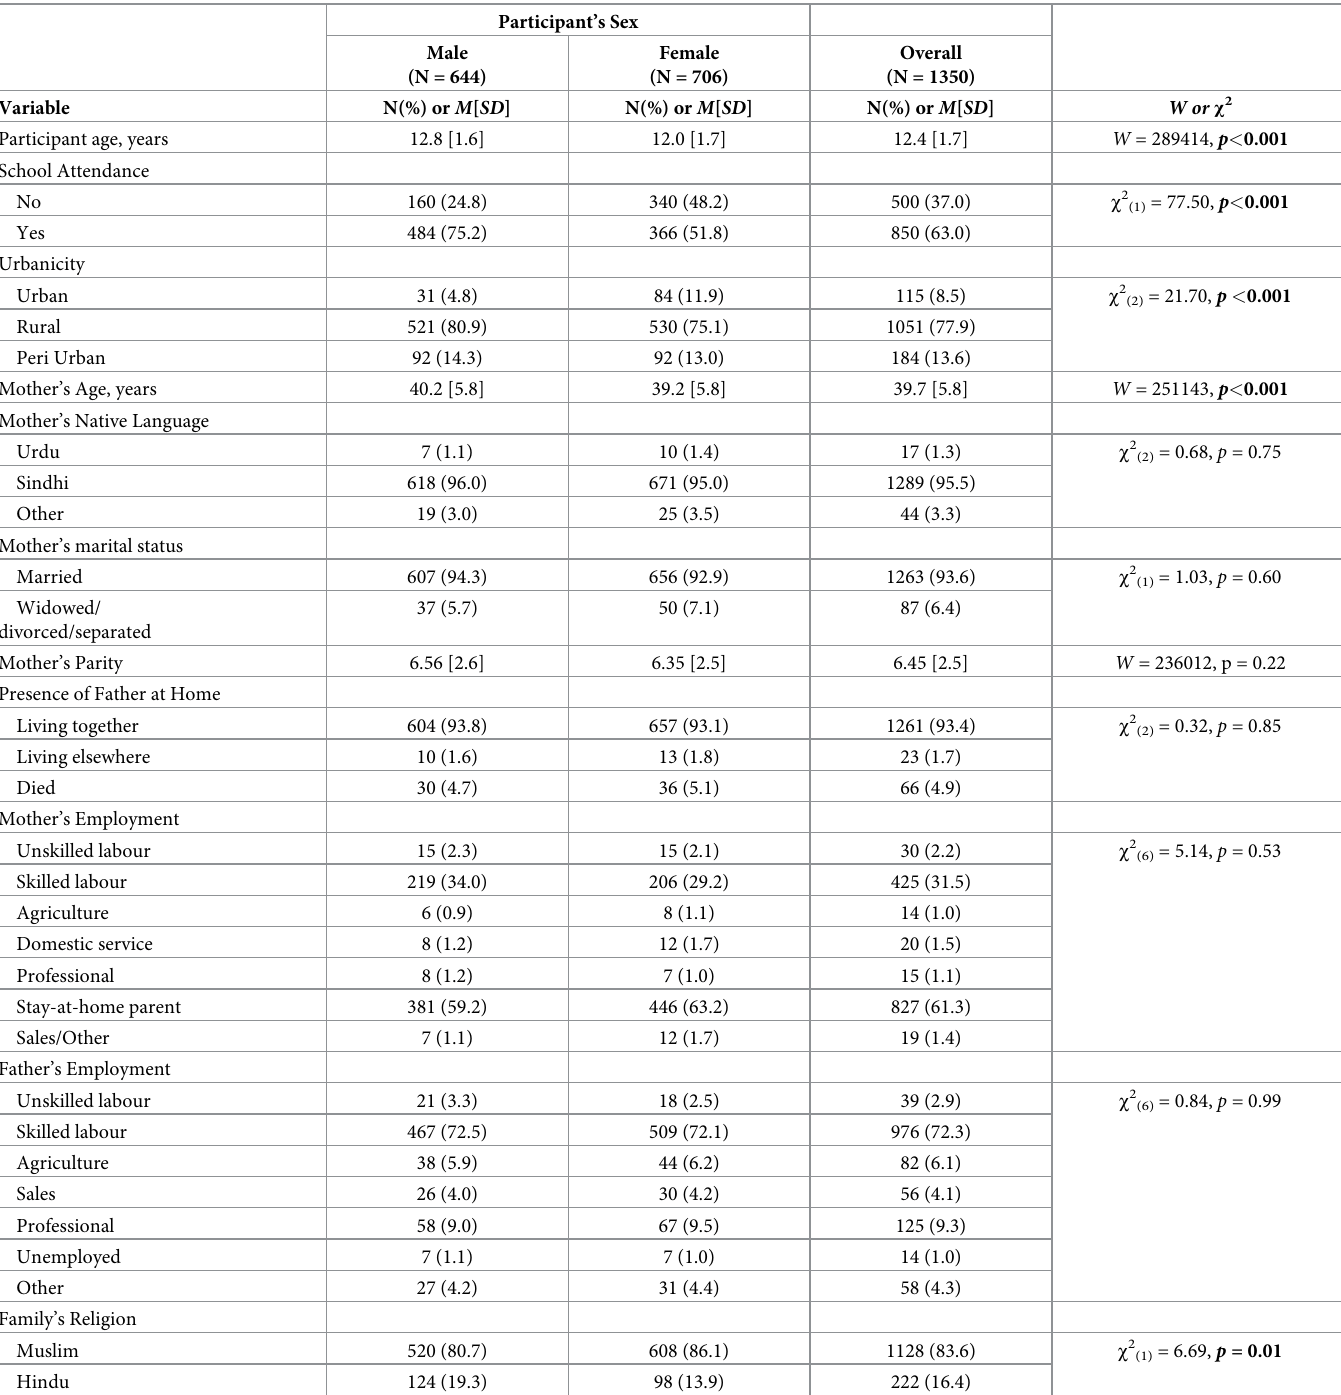
Table 1. Demographic and family characteristics of